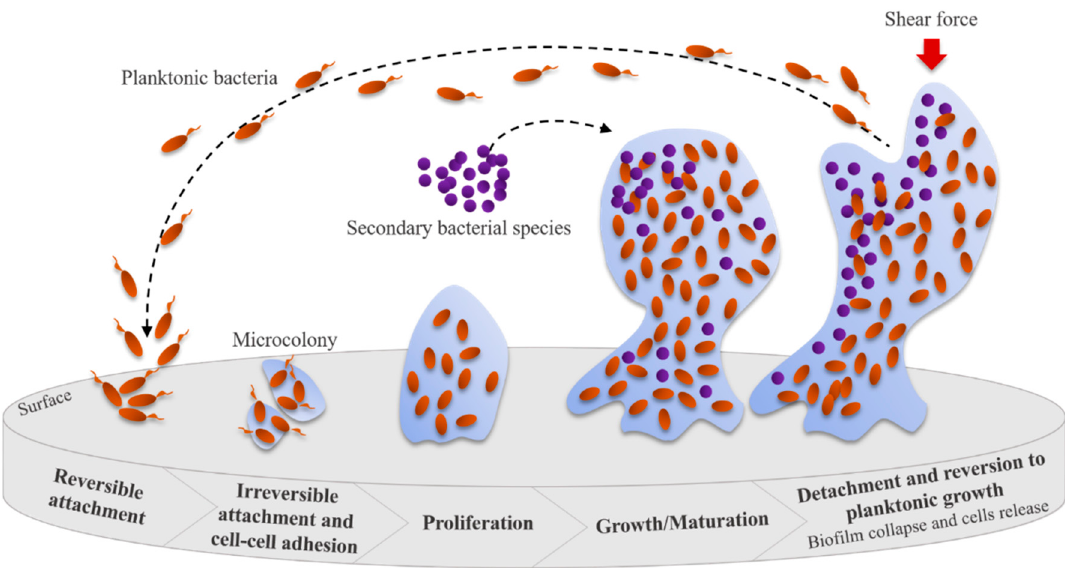
Figure 4. Steps leading to bacterial biofilm formation Adapted from [60].